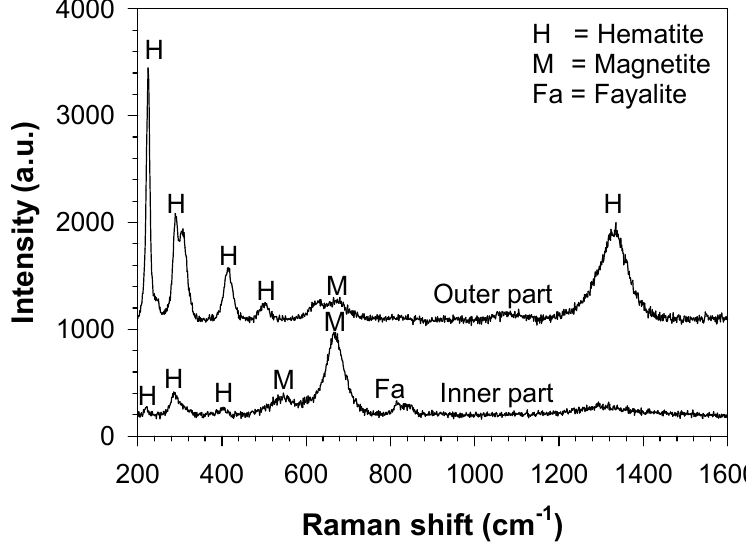
Figure 5. Raman patterns of the bare cast iron after cyclic oxidation at 850 °C in N 2 –12O 2 –10H 2 O for 14 cycles.